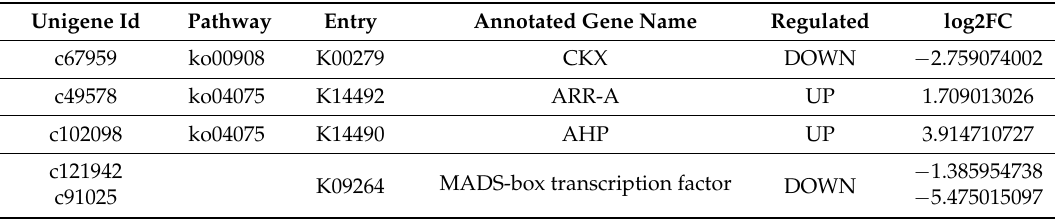
Table 5. The Unigenes in DEGs by KEGG.